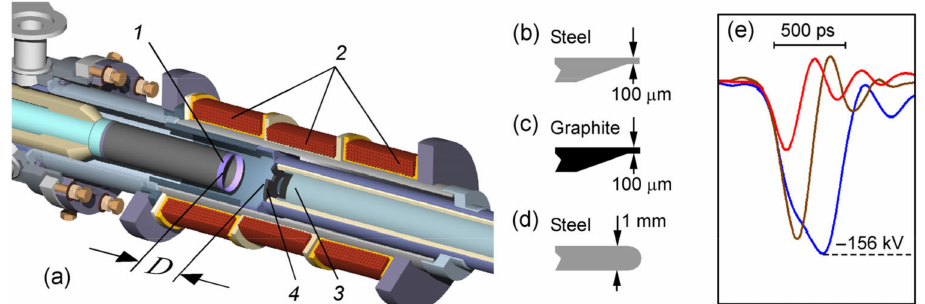
Figure 1. ( a ) The beam injector unit with a cold tubular cathode (1), pulse solenoid (2), and collector current probe (3) with segment collimator (4). ( b – d ) Edge options for the tubular cathodes having an outer diameter of 22 mm. ( e ) Adjustable voltage pulses formed by a high-voltage generator to feed the cathode.